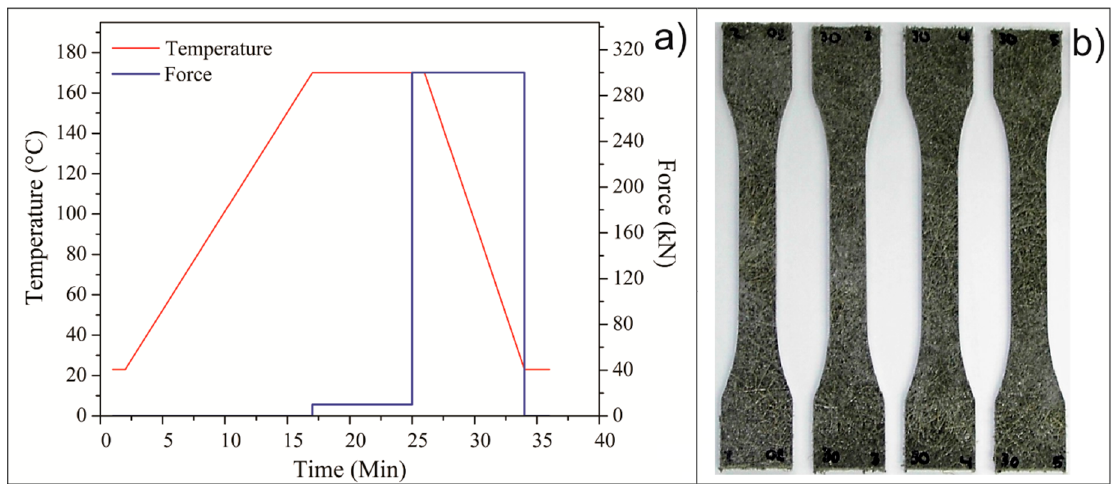
Figure 1. ( a ) Manufacturing process cycle, and ( b ) appearance of specimens after the process of routing and sanding.